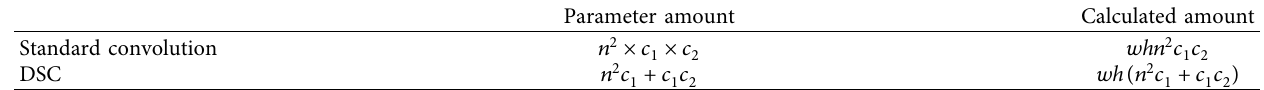
Table 1: Comparison of standard convolution and DSC. Parameter amount Calculated